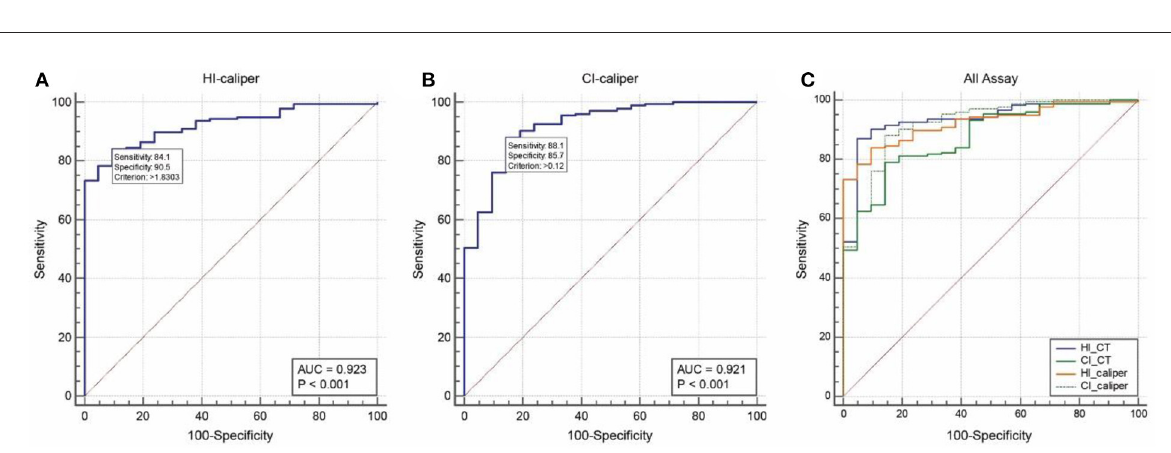
group revealed that HI-caliper was strongly correlated with HI-CT (rs = 0.70, p < 0.001), while CI-caliper was strongly correlated with CI-CT (rs = 0.69, p < 0.001) (Figure 3).